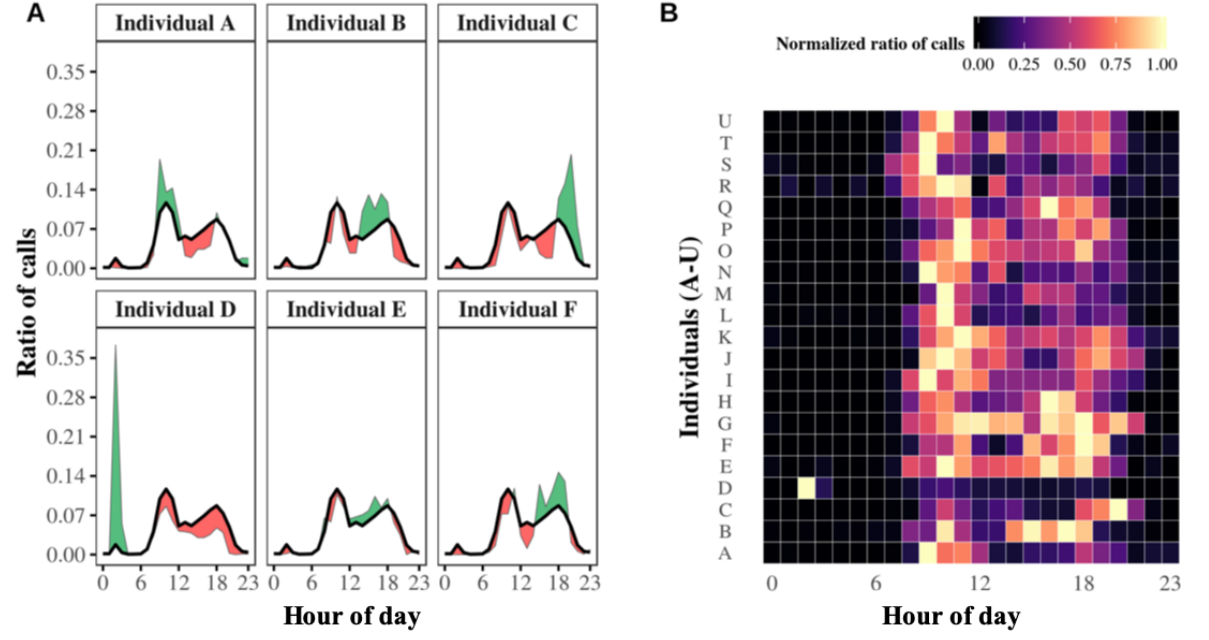
Figure 3. Circadian patterns of outgoing telephone call activities at the individual level. Panel A. Individual circadian patterns of the outgoing telephone call activity profiles of 6 distinct egos. Each small graph shows a specific ego. The black line represents the average circadian pattern of outgoing telephone calls for the population, whereas the individual’s circadian pattern of calling is represented by a green or red area indicating higher or lower outgoing telephone calls than the average. Panel B. Heat map showing 21 individual outgoing telephone call patterns. The entire population’s normalized individual circadian patterns are shown aggregated onto one heat map. Each horizontal strip summarizes the circadian pattern of one ego, associating each hour of the day with the corresponding ratio of outgoing telephone calls in appropriately colored boxes. The greater the ratio of outgoing telephone calls, the brighter the corresponding